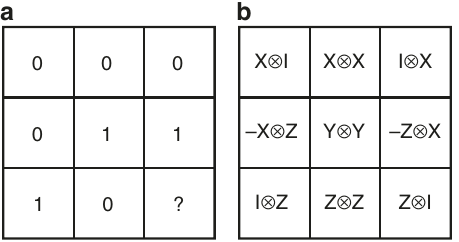
Fig. 2 Classical and quantum strategies for the magic square game. a An optimal classical strategy for the magic square game that allows Alice and Bob to win the game for 8 of the 9 possible questions. Filling the bottom right square consistently with the parity constraints for the rows (even) and columns (odd) is impossible. b A perfect quantum strategy de fi ned by measuring the observables in the cells on two maximally entangled states. Note that the observables along each row and column commute